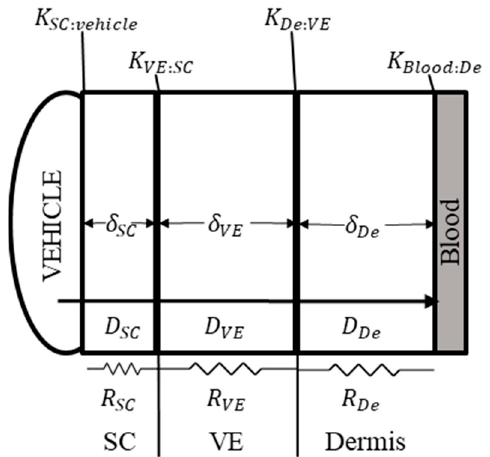
Figure 2. Basic diagram of 1D model for simulating transdermal permeation in BIOiSIM. D i is the diffusion coefficient for a compound across each respective skin layer; K i:g is the partition coefficient boundary condition at each layer interface; R i is the resistance to permeation; and δ is the thickness of each layer. SC = Stratum corneum; VE = viable epidermis; De = Dermis.